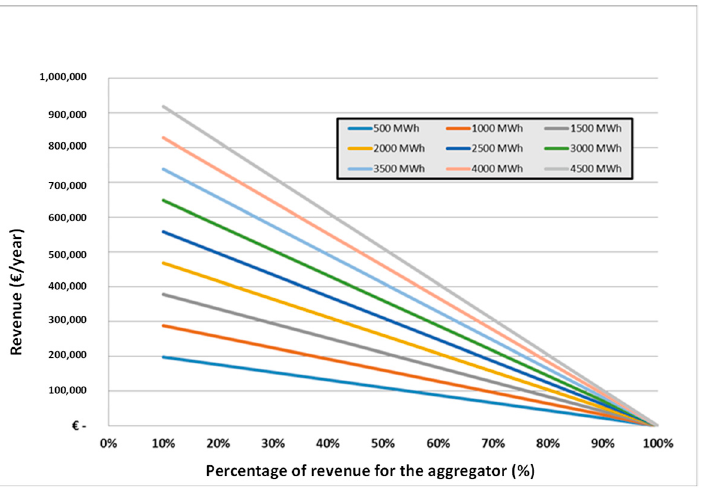
Figure 11. UVAM users’ revenues for a value of the energy sale price of 200 €/MWh, depending on the percentage of aggregator revenue and parameterized according to the amount of energy exchanged annually with the TSO.